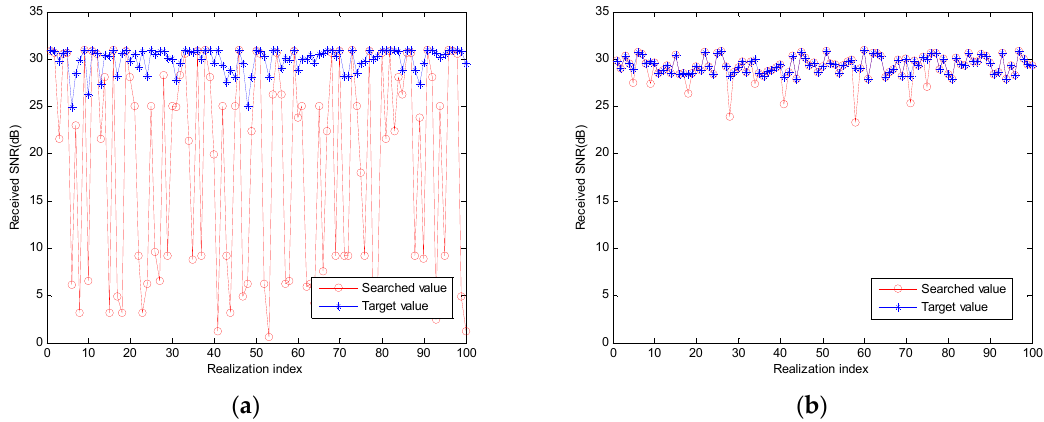
Figure 4. Performance of the boundary definition method. ( a ) Classical technique; ( b ) Wrapping around of the boundary.